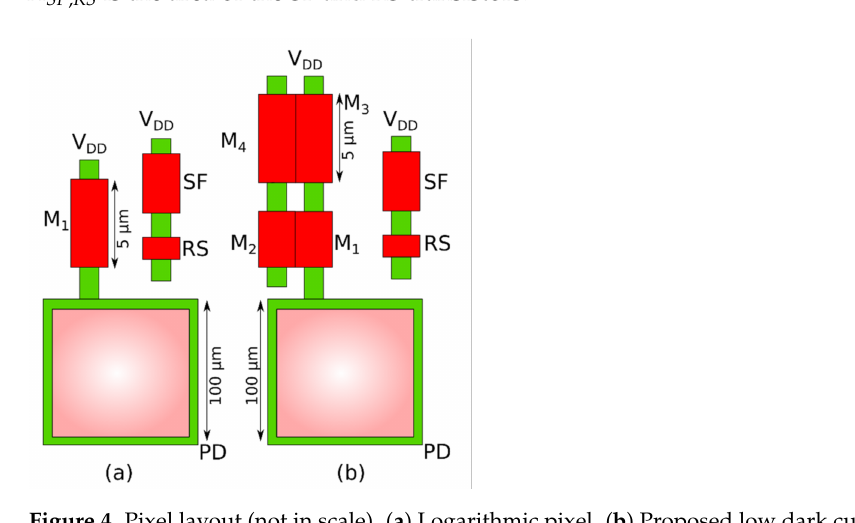
Figure 4. Pixel layout (not in scale). ( a ) Logarithmic pixel. ( b ) Proposed low dark current pixel. The diffusion is in green, the polysilicon is in red and the photodiode sensitive area is in pink.